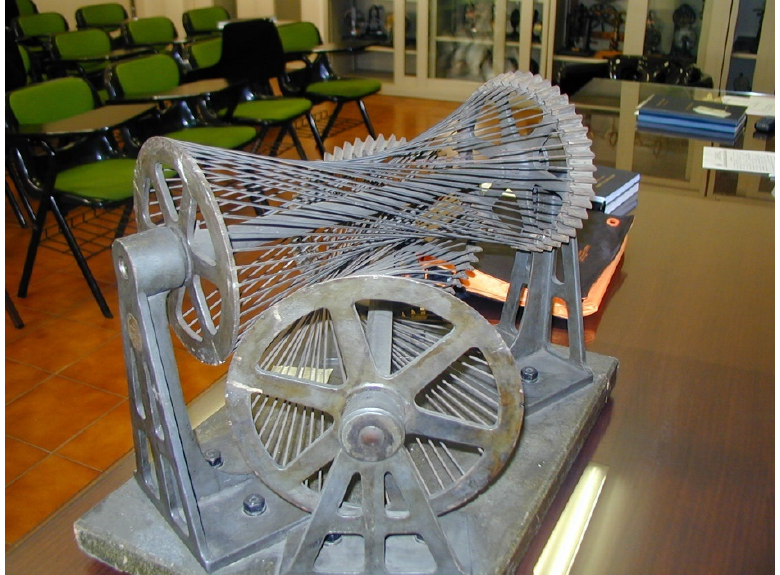
Figure 16. The iron-made model of the hypoid connections representing the screw motion and hypoid gears.